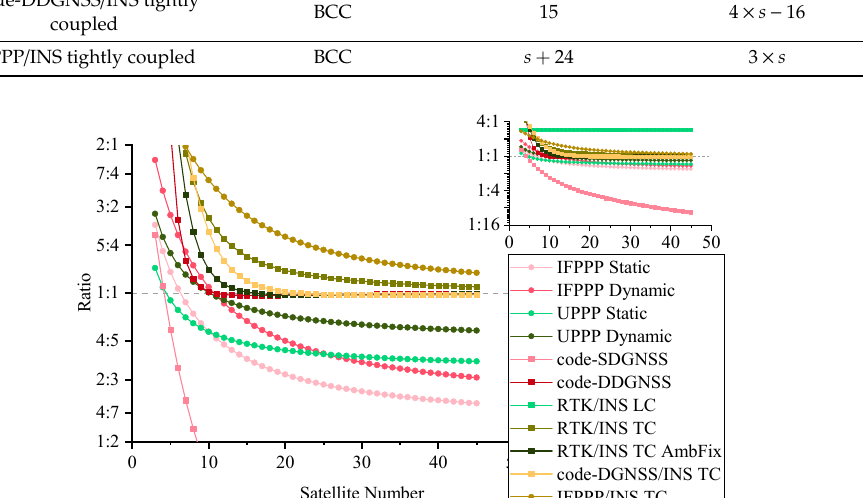
Figure 4. Computational cost ratio